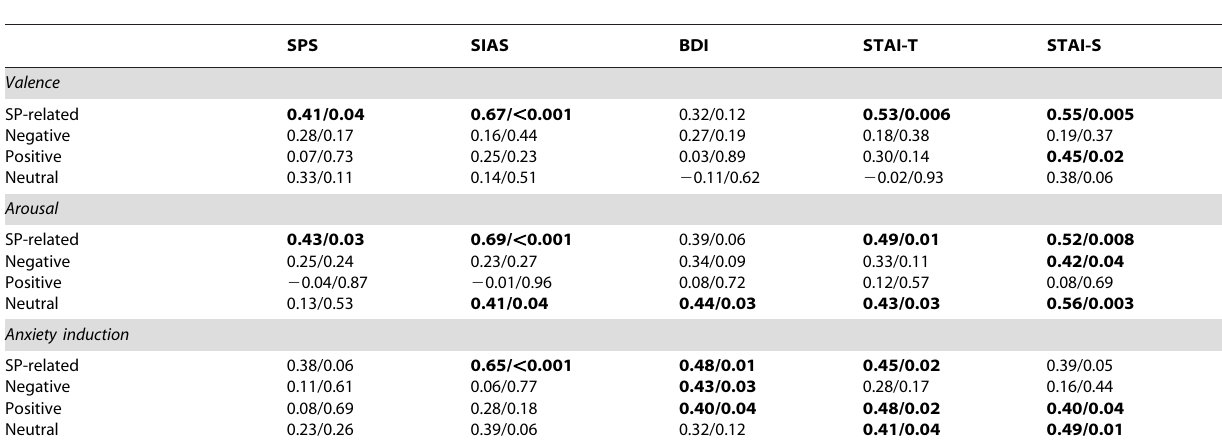
Table 3. Correlations between the clinical measures and the behavioral rating data for negative, SP-related, positive, and neutral words within the group of social phobia patients (Pearson’s correlation/p-value